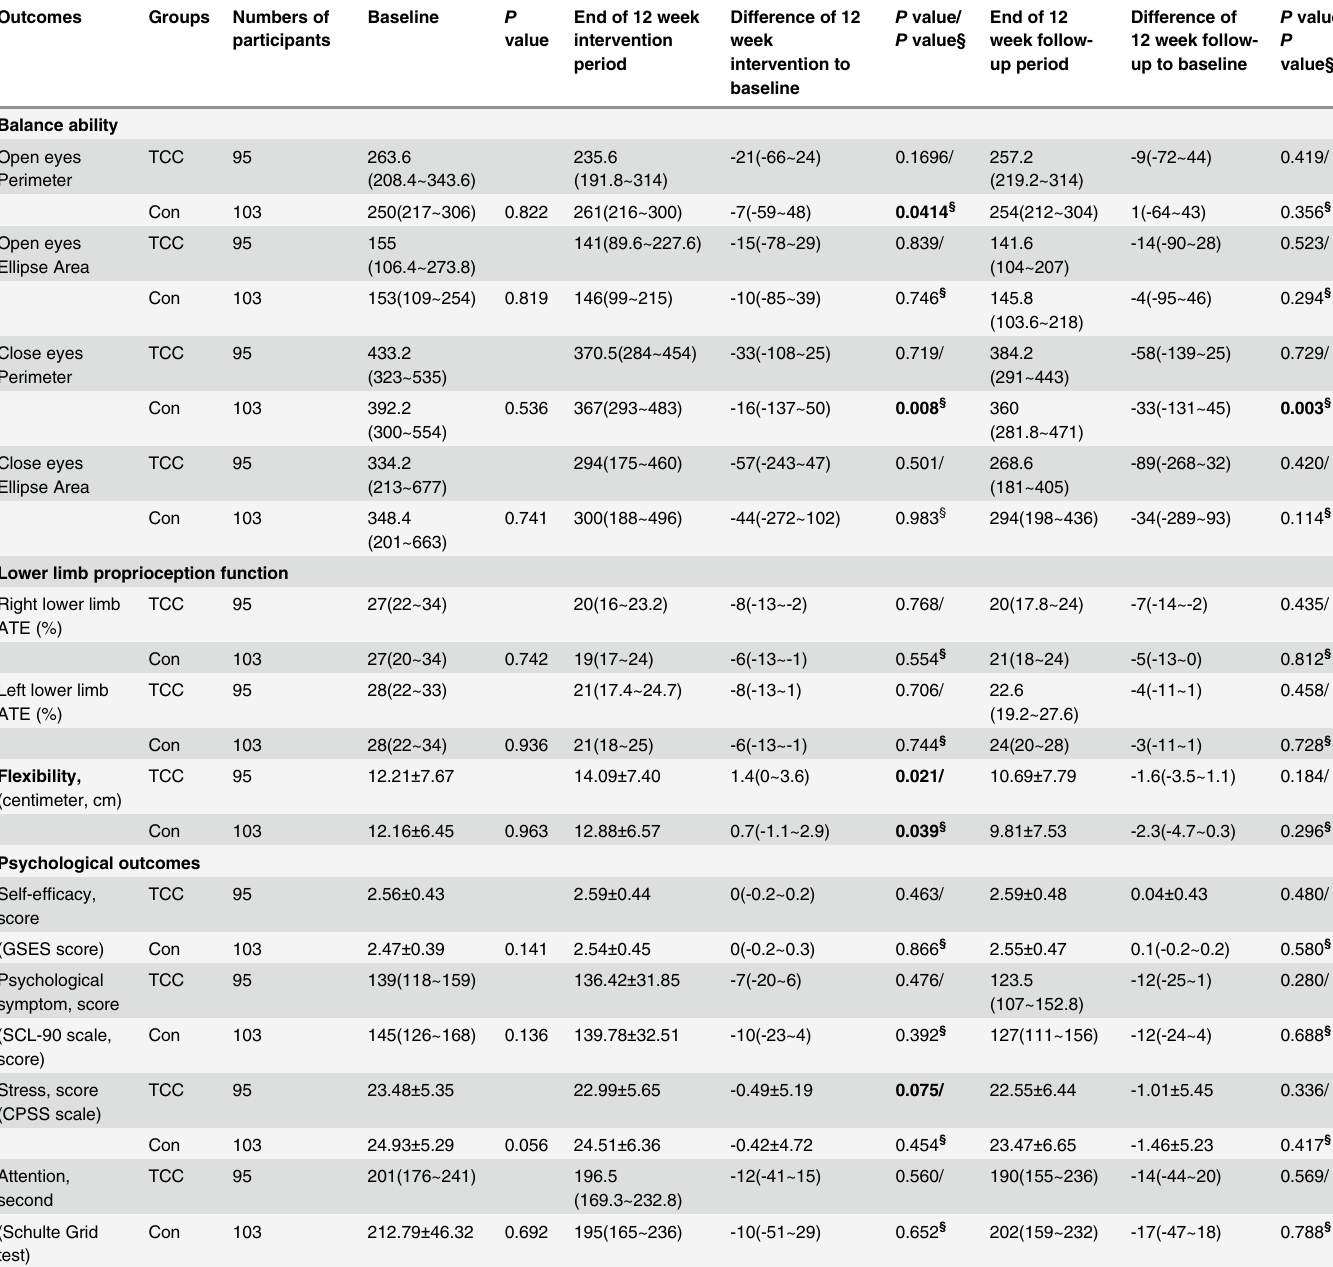
Table 3. Primary outcomes on physical and psychological health (Mean ± SD/ Median (Inter-quartile range).